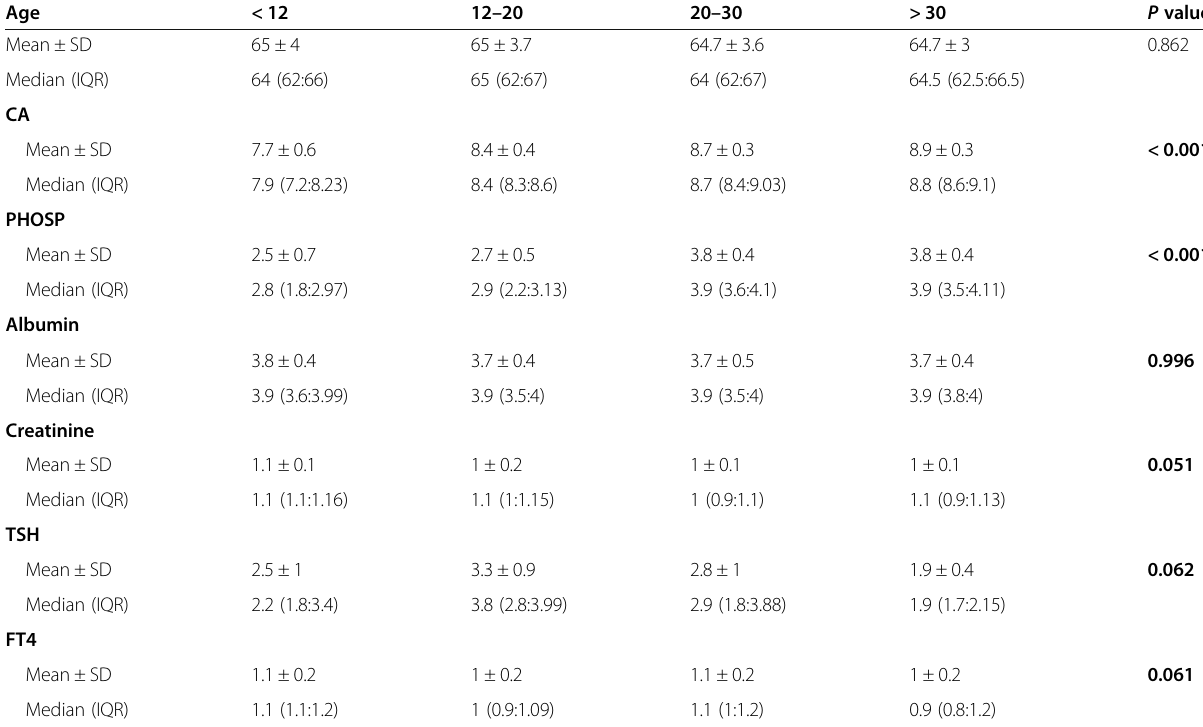
Table 3 Descriptive of all quantitative